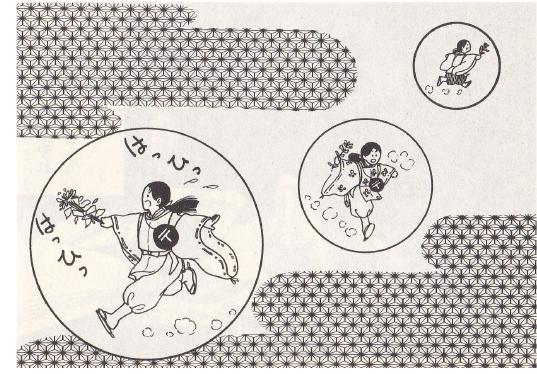
Figure 7. A boy delivers